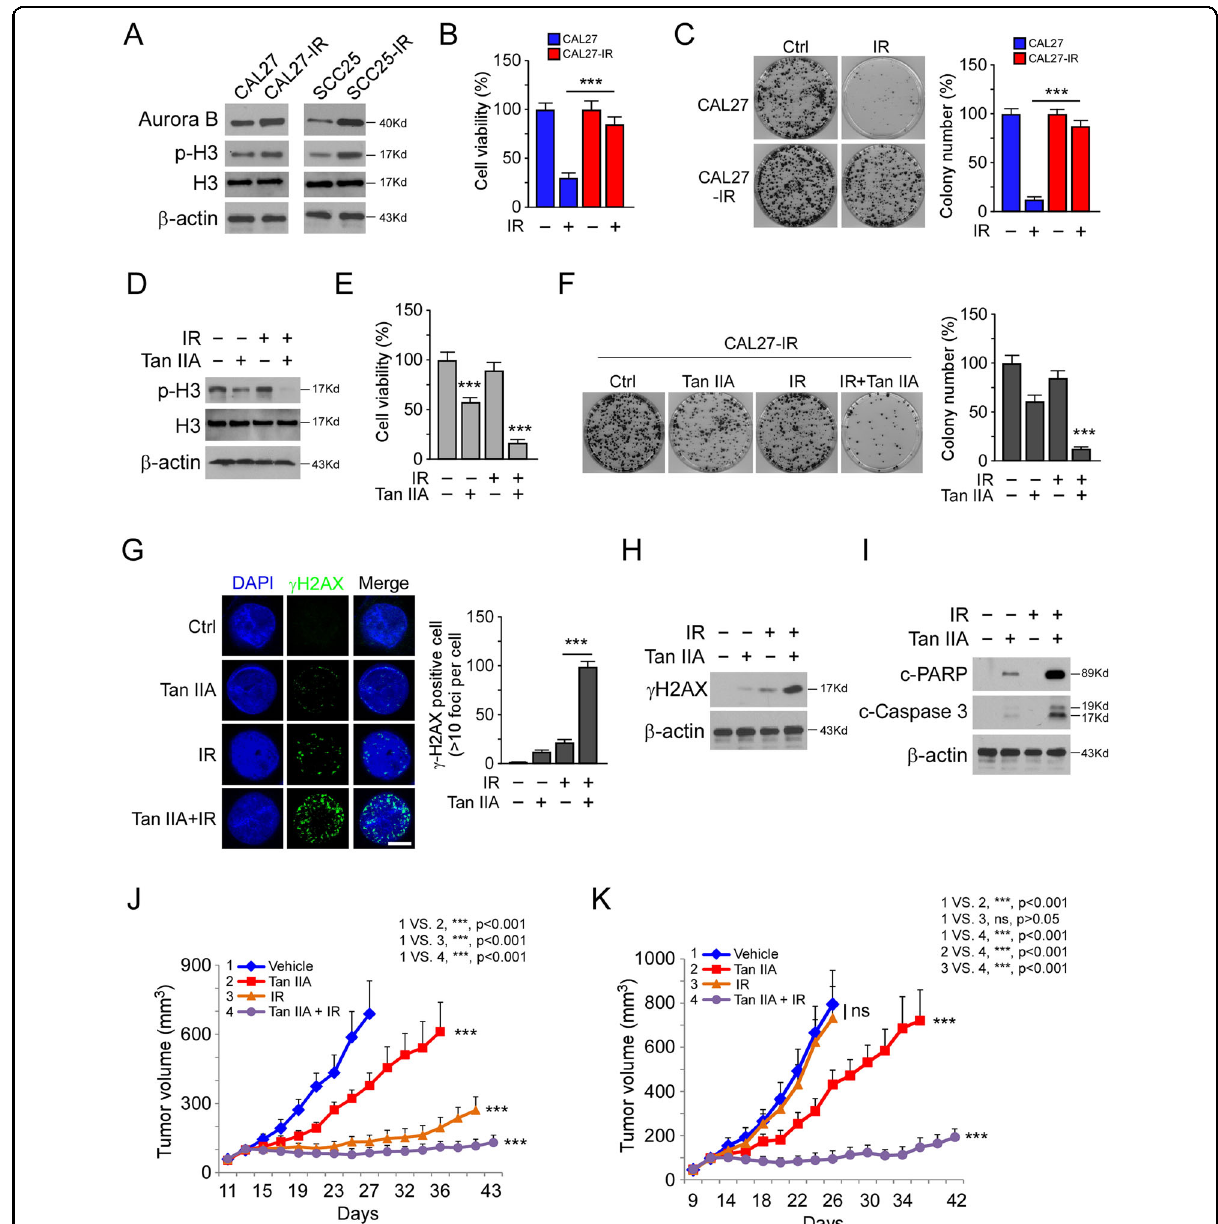
Fig. 7 Tan IIA overcomes radioresistance in OSCC cells. A IB analysis of the protein level of Aurora B and p-H3 in CAL27/CAL27-IR and SCC25/ SCC25-IR cells. B The effect of irradiation (IR) on cell viability of CAL27/CAL27-IR cells. CAL27 and CAL27-IR cells were treated with 4 Gy IR, cell viability was examined 72 h later by MTS assay; *** p < 0.001. C The effect of IR on colony formation of CAL27/CAL27-IR cells. CAL27 and CAL27-IR cells were treated with 4 Gy IR, colony number was examined 2 weeks later; *** p < 0.001. D IB analysis of the protein level of Aurora B and p-H3 in CAL27-IR cells treated with Tan IIA (2 μ M), IR (4 Gy), or a Tan IIA/IR combination. E and F The cell viability ( E ) and colony formation ( F ) of CAL27-IR cells treated with Tan IIA (2 μ M), IR (4 Gy), or a Tan IIA/IR combination; *** p < 0.001. G and H Immuno fl uorescence ( G ) or IB ( H ) analysis of γ H2AX in CAL27-IR cells treated with Tan IIA (2 μ M), IR (4 Gy), or a Tan IIA/IR combination. Scale bar, 5 μ m; *** p < 0.001. I IB analysis of apoptosis in CAL27-IR cells treated with Tan IIA (2 μ M), IR (4 Gy), or a Tan IIA/IR combination. J In vivo tumorigenesis of CAL27 cells treated with vehicle control, Tan IIA, IR, or a Tan IIA/IR combination; *** p < 0.001. K In vivo tumorigenesis of CAL27-IR cells treated with vehicle control, Tan IIA, IR, or a Tan IIA/IR combination; *** p < 0.001; ns, not statistically signi fi